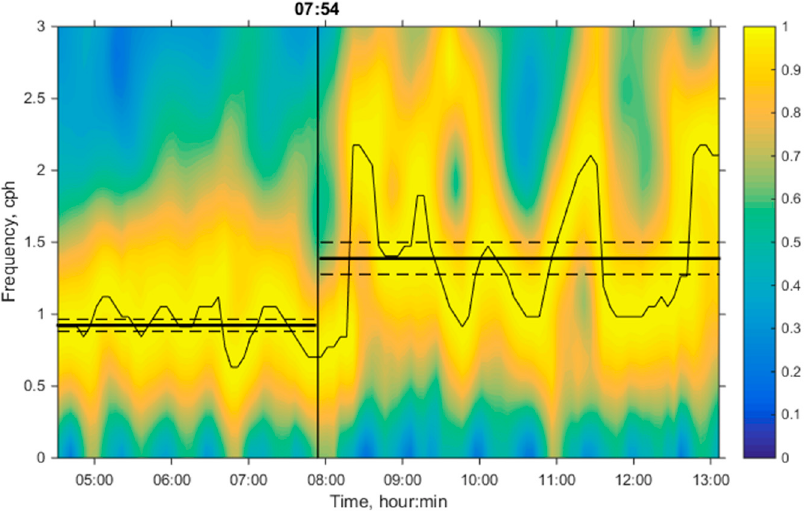
Figure 11. Dominating frequency on the spectrogram using the Hamming window.